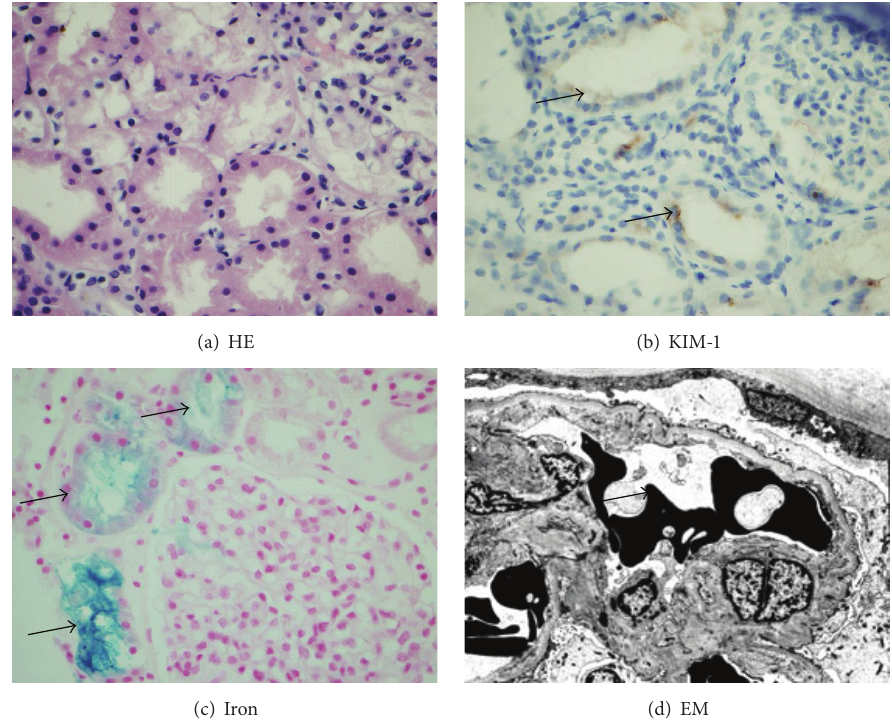
Figure 1: Iron deposition associated with acute tubular injury in the allograft kidney. (a) Dilated proximal tubules with focal disruption of brush border. No inflammatory infiltration is seen (hematoxylin and eosin, original magnification × 400). (b) Acute tubular injury was confirmed by positive kidney injury molecule-1 staining (arrow) along the luminal surface of proximal tubules (original magnification × 400). (c) Iron staining was moderately (2+) positive in the injured proximal tubules (arrow) (original magnification × 400). (d) Electron photomicrograph depicting sickle shaped red blood cells (arrow) clustered in the glomerular capillary loops (original magnification ×